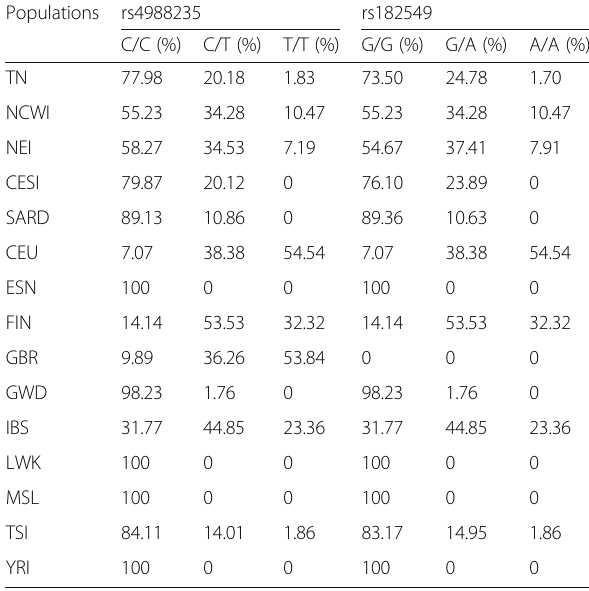
Table 2 Genotypic frequencies for functional SNPs in the